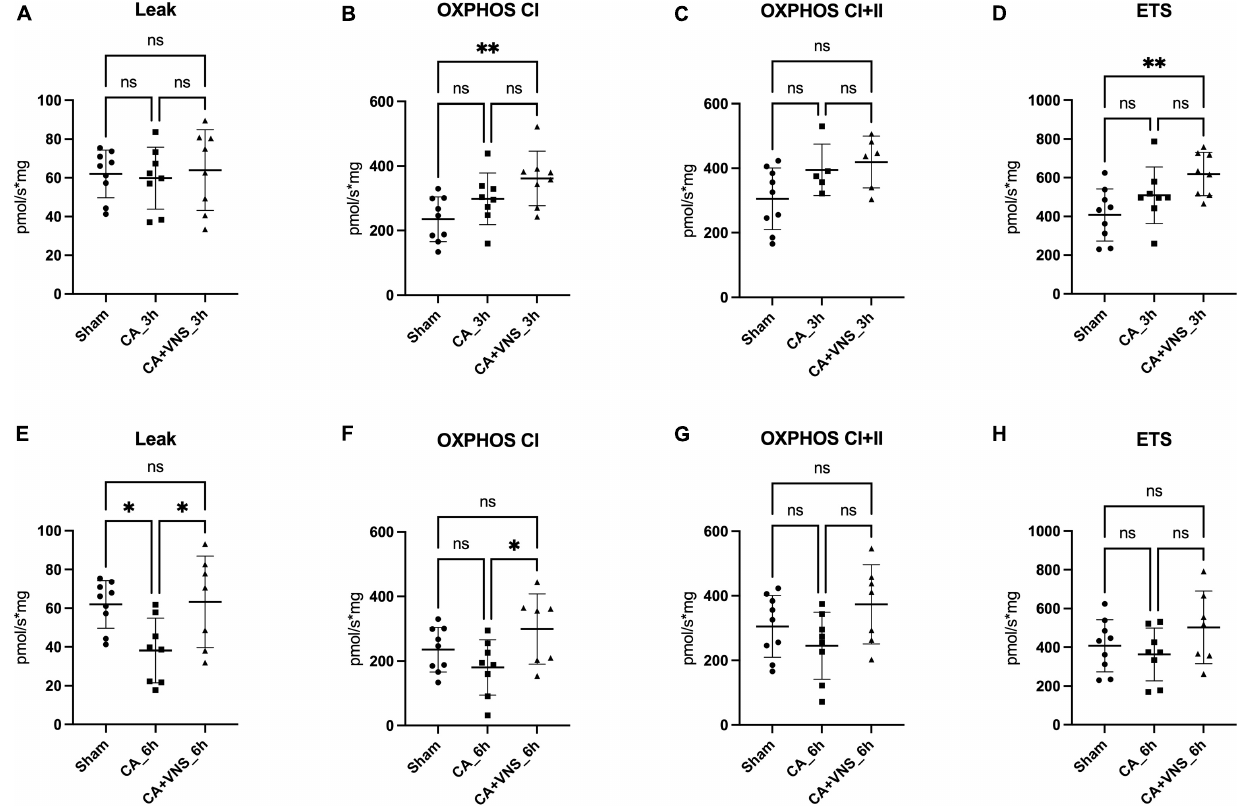
Frontiers in Neuroscience |